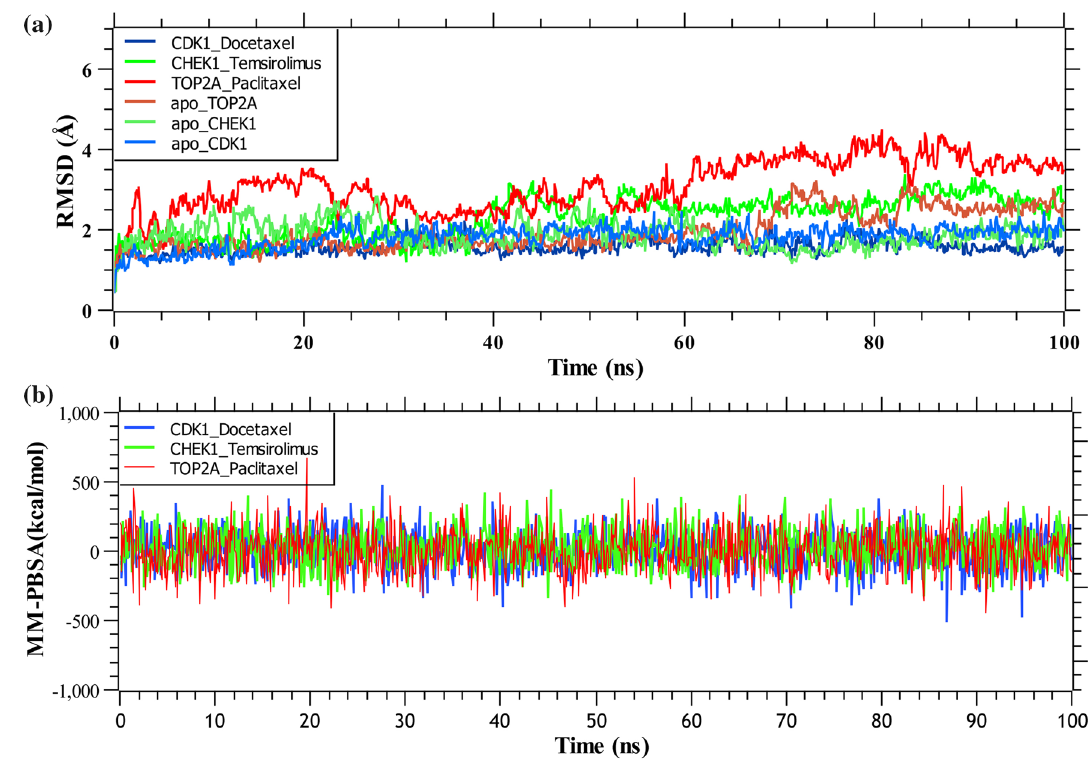
Fig. 8 a Time evolution of root-mean-square deviations (RMSDs) of backbone atoms (C, Cα, and N) for protein for top-ranked three com- plexes. b Molecular mechanics Poisson-Boltzmann surface area (MM-PBSA) analysis was used to determine the binding free energy (kJ/mol) of each snapshot, which represents the change in binding stability of each complex across simulations; positive values indicate better bind- ing. Complexes: Dark blue docetaxel-CDK1, green temsirolimus-CHEK1, red paclitaxel-TOP2A, light blue apo-CDK1, light green apo-CHEK1, light red